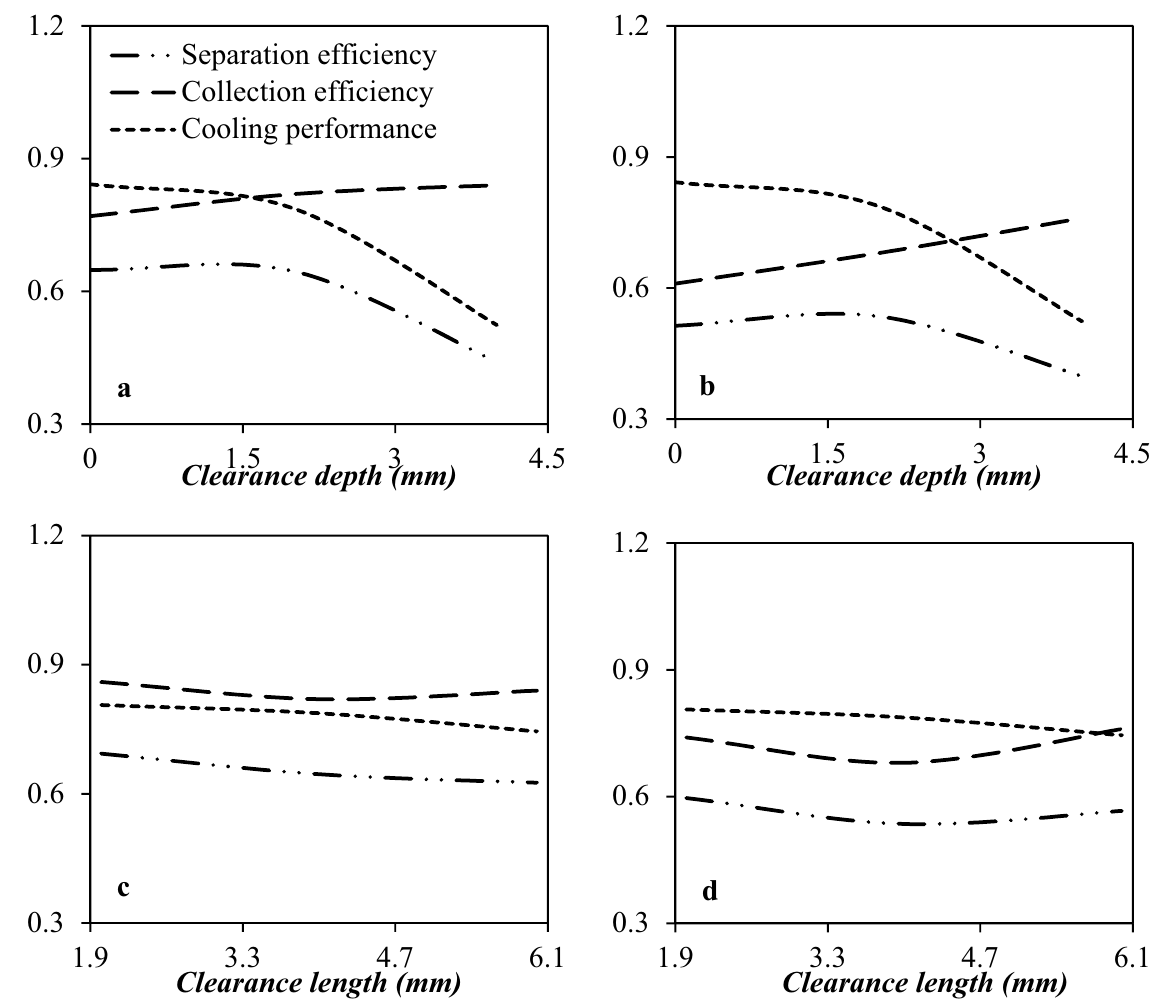
Figure 14. The influence of clearance depth ( a , b ) and clearance length ( c , d ) on the collection efficiency, cooling performance and separation efficiency of 3S for ( a , c ) water droplets and ( b , d ) HC